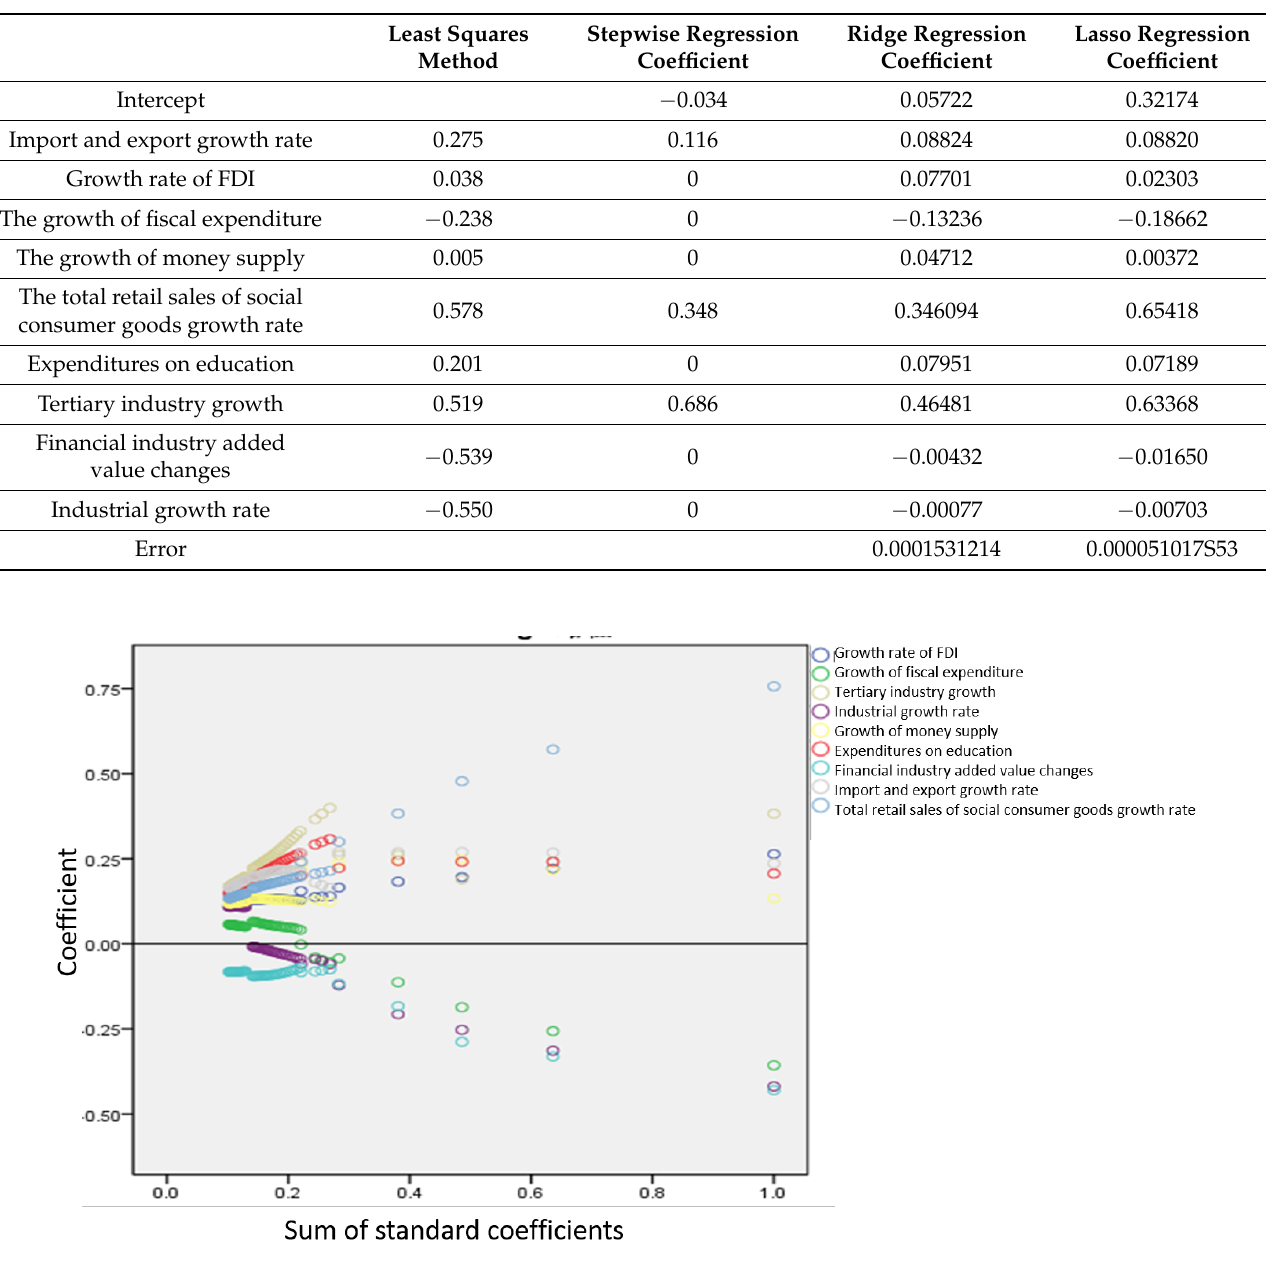
Table 5. Comparison of regression coefficients.